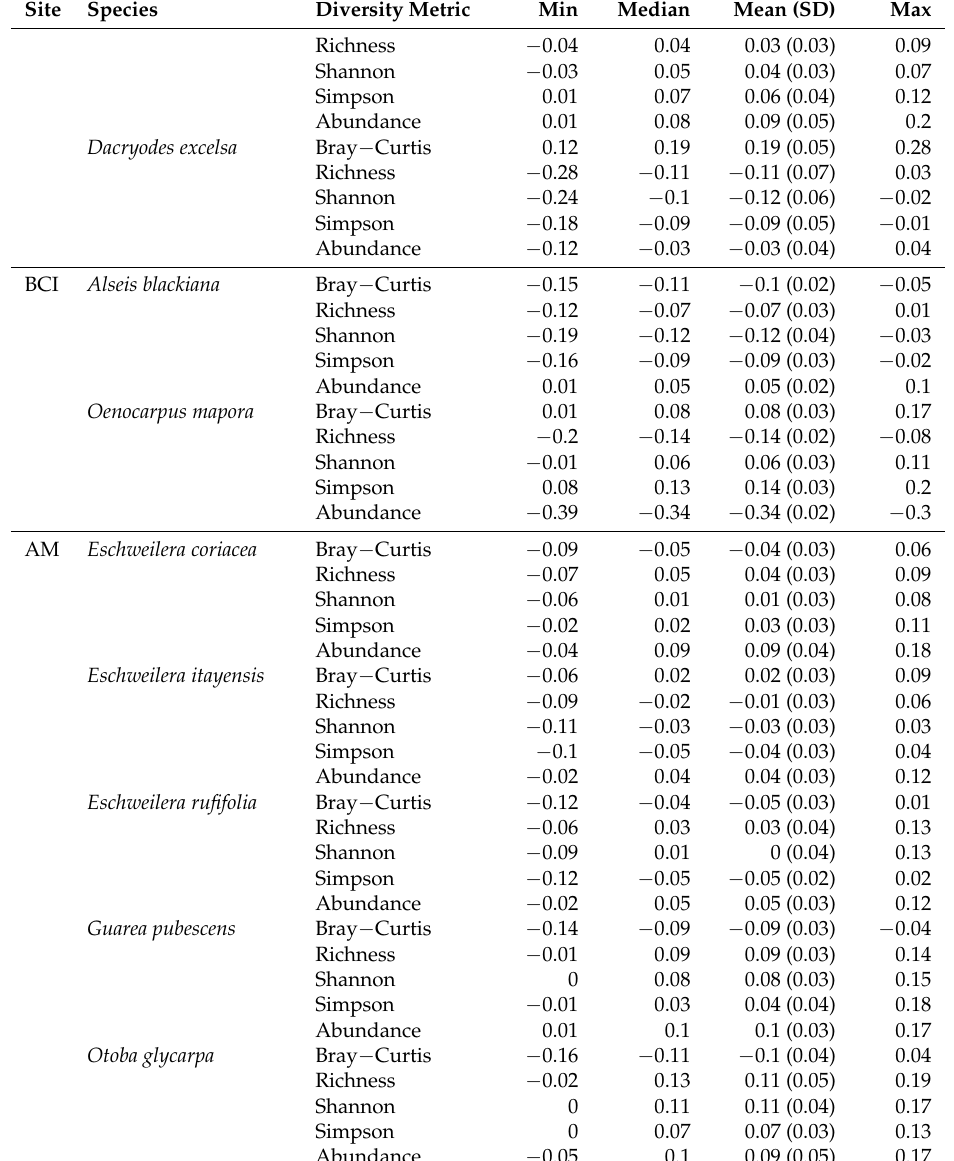
Table A2. Codispersion statistics for focal tree species in tropical forests (Figures 15–20 and Figures